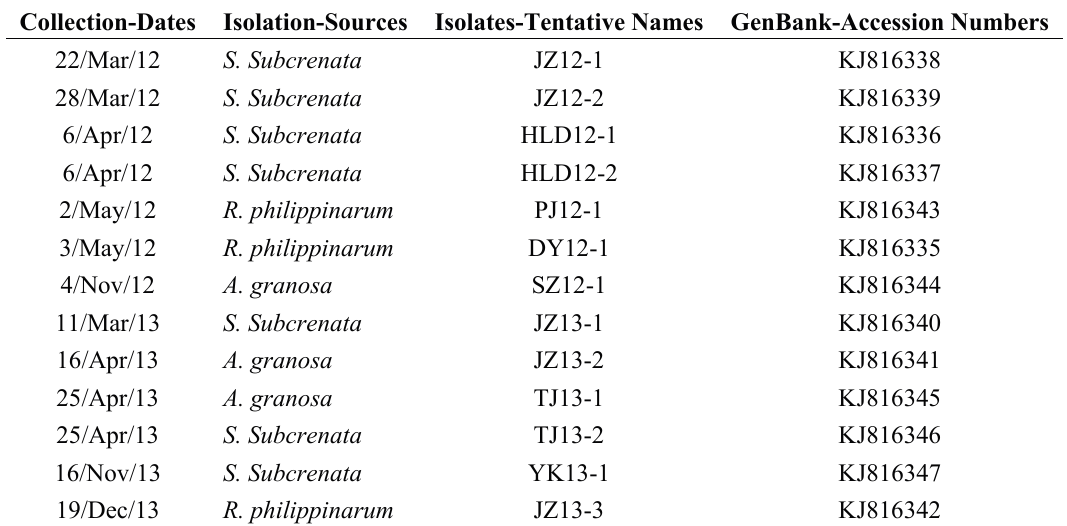
Table 2. List of thirteen identified HEV RNA isolates from different species shellfish.